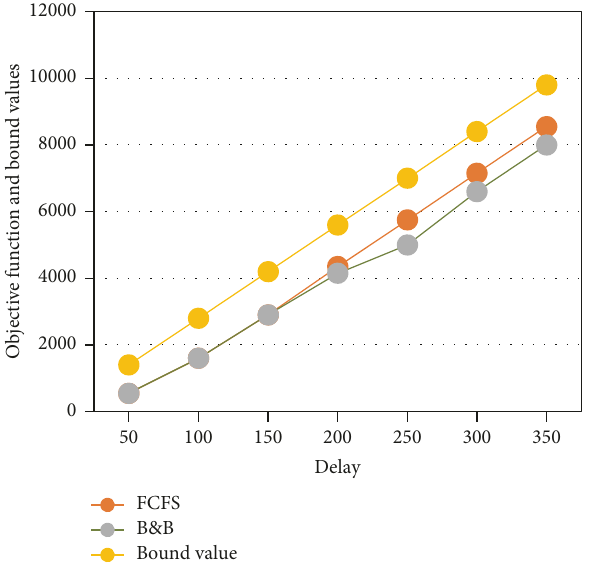
Figure 8: Simulation results in case of different delays.